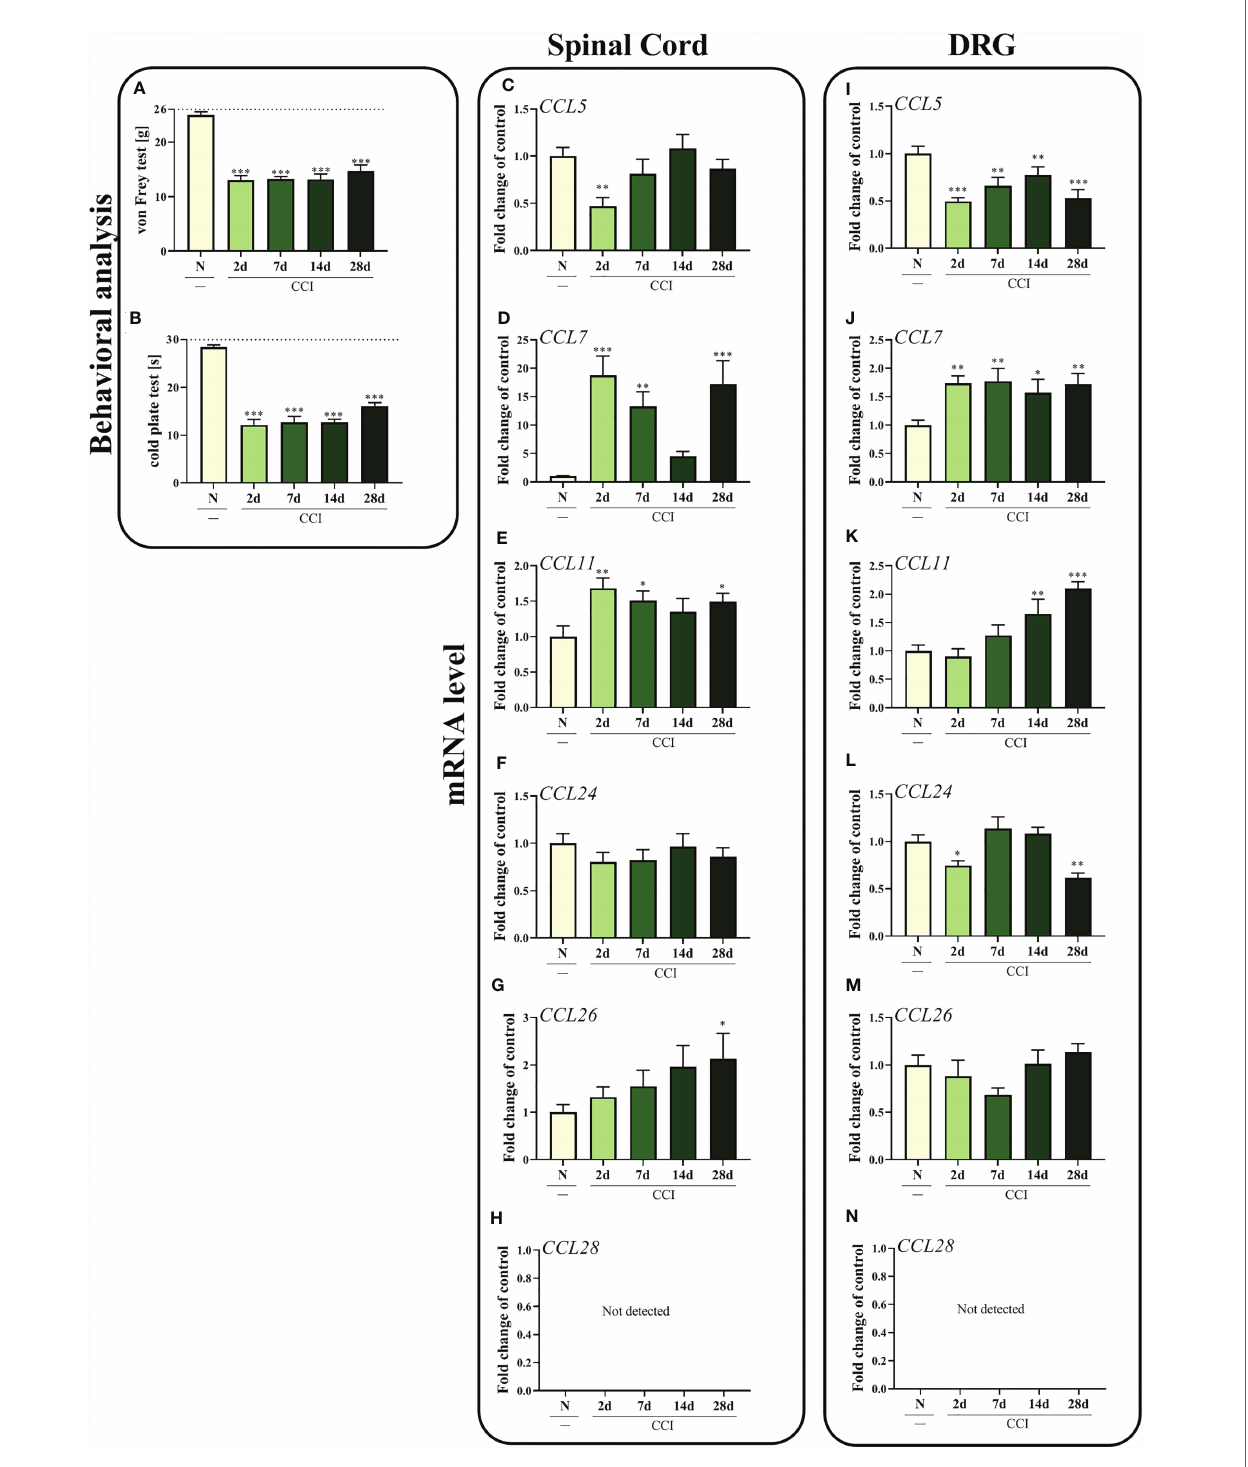
FIGURE 1 | Time-dependent changes in pain-related behaviors in rats on the 2 nd , 7 th , 14 th and 28 th days after chronic constriction injury of the sciatic nerve [CCI; (A) , von Frey test; (B) , cold plate test] and associated changes in CCL5, CCL7, CCL11, CCL24, CCL26 , and CCL28 mRNA levels in the spinal cord (C – H) and DRG (I – N) . The behavioral data are presented as the means ± SEM of 10 rats per group. For behavioral studies (A, B) , the horizontal dotted line shows the cutoff value. The RT – qPCR data are presented as the means ± SEM of 6 – 9 samples per group. Intergroup differences were analyzed using ANOVA with Bonferroni ’ s post hoc test for multiple comparisons. *P < 0.05, **P < 0.01, and ***P < 0.001 indicate a signi fi cant difference compared with the control group (naive, N